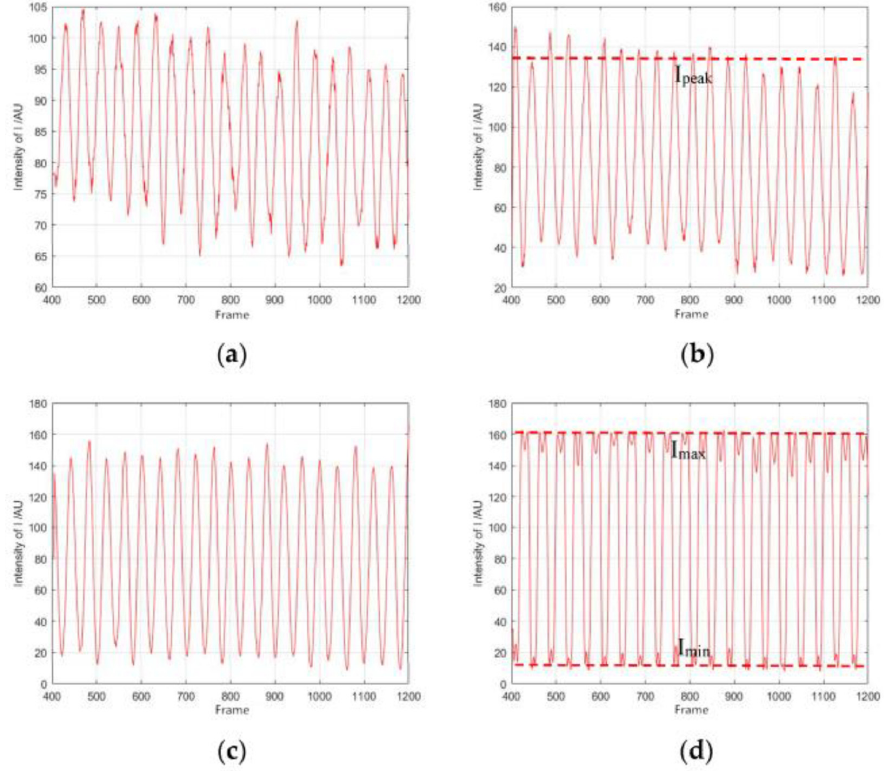
Figure 9. The light intensity curves of different amplitudes when the frequency f is 10 Hz. ( a ) A = 10 nm; ( b ) A = 30 nm; ( c ) A = 50 nm; ( d ) A = 80 nm. In order to obtain the vibration amplitude, we need to calculate the values of I 1 , I 2 and the peak value I peak . When frequency doubling phenomenon occurs, the maximum value I max or minimum value I min can be obtained. When the amplitude is too large, as